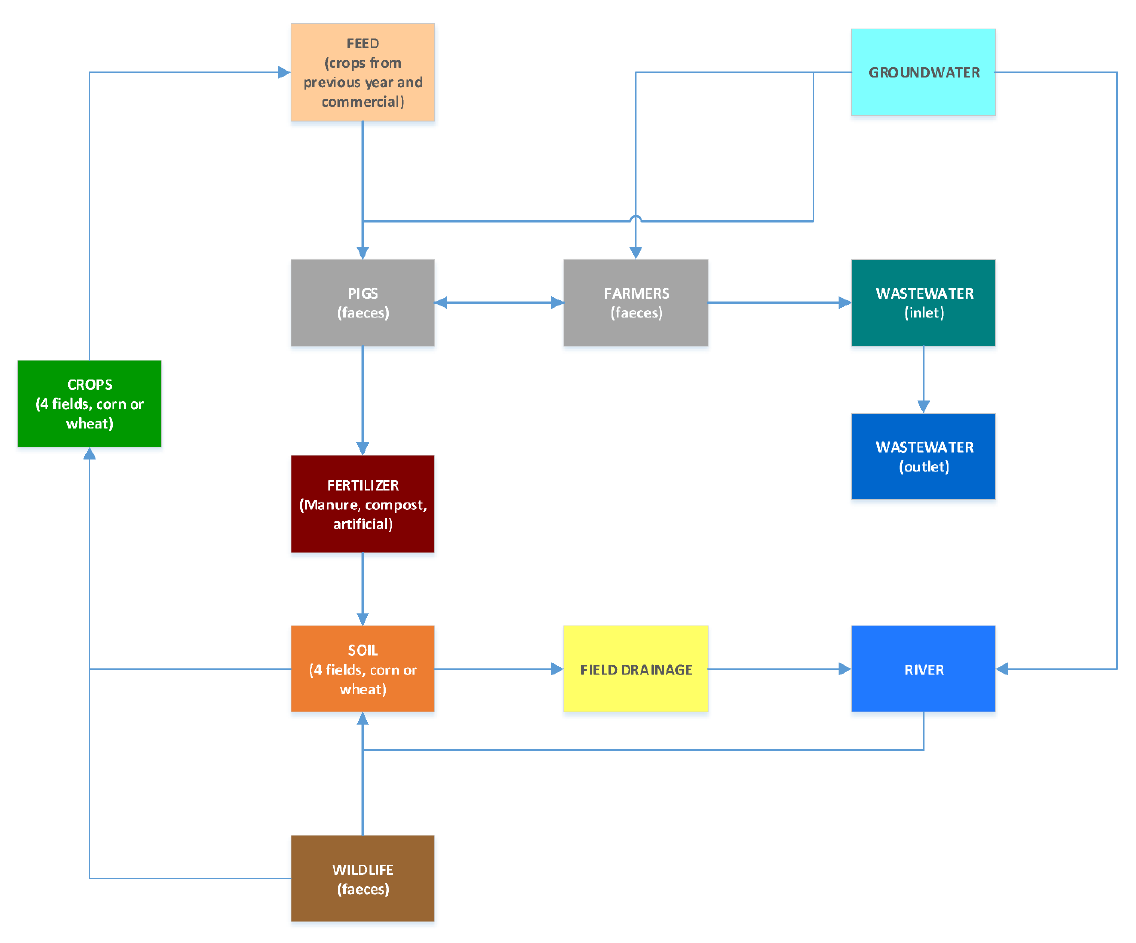
Figure 3. Graphical representation of the relationship between the different HOAL compartments from which samples were collected. Grey compartments are those from which no sample could be obtained.